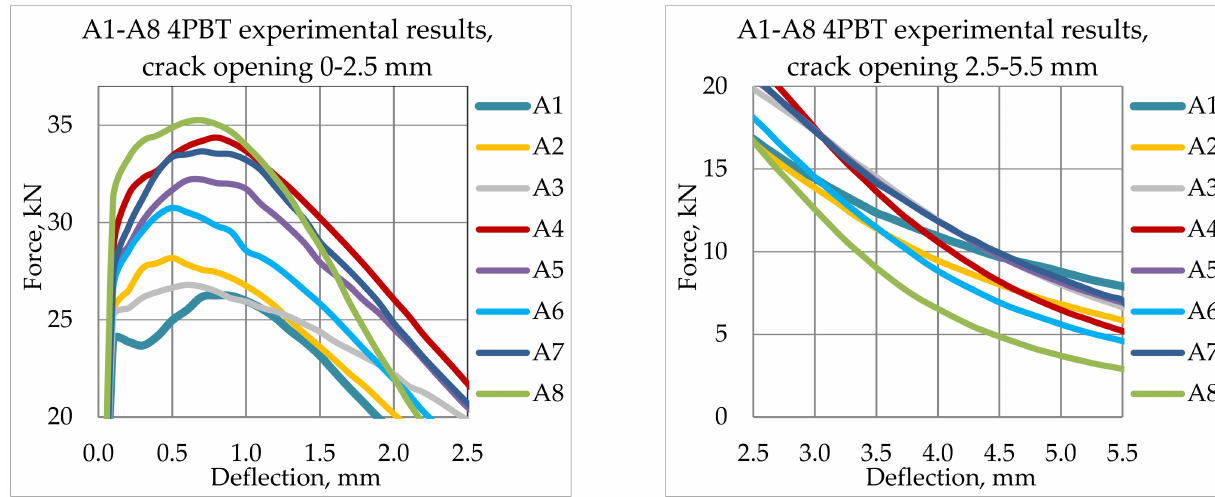
Figure 23. Average 4PBT experimental result curves of all specimen